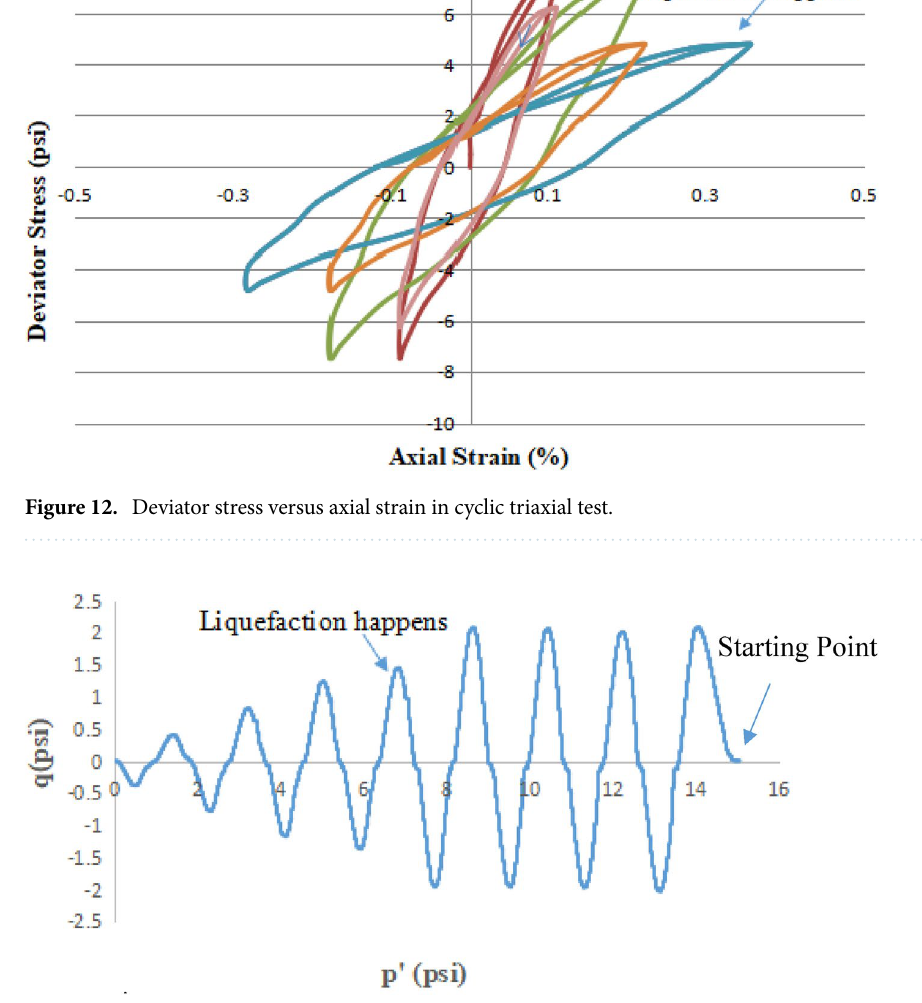
Figure 13. p ′ versus q stress path in cyclic hollow cylinder